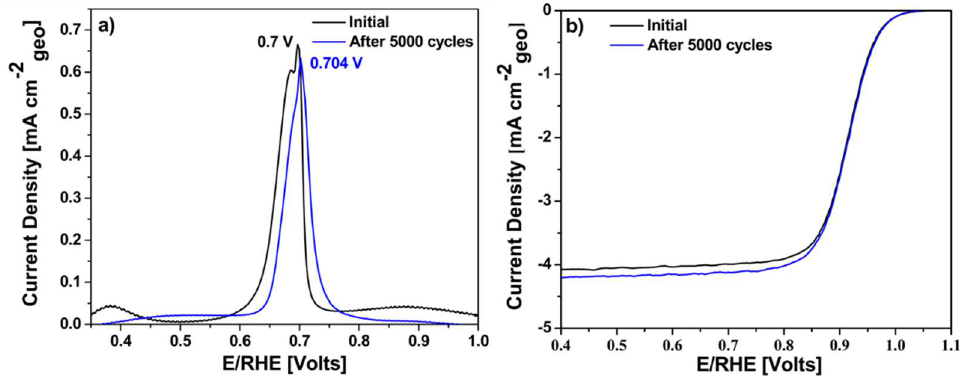
Figure 7. ( a ) CO electrooxidation peaks of Pt 2 NiCo / C nanocatalyst initial and after the 5000 CVs with a scan-rate of 20 mV s − 1 . ( b ) Potentiodynamic polarization curves of the Pt 2 NiCo / C nanocatalyst initial and after the 5000 CVs measured at 1600 rpm with a scan rate of 20 mV s − 1 .